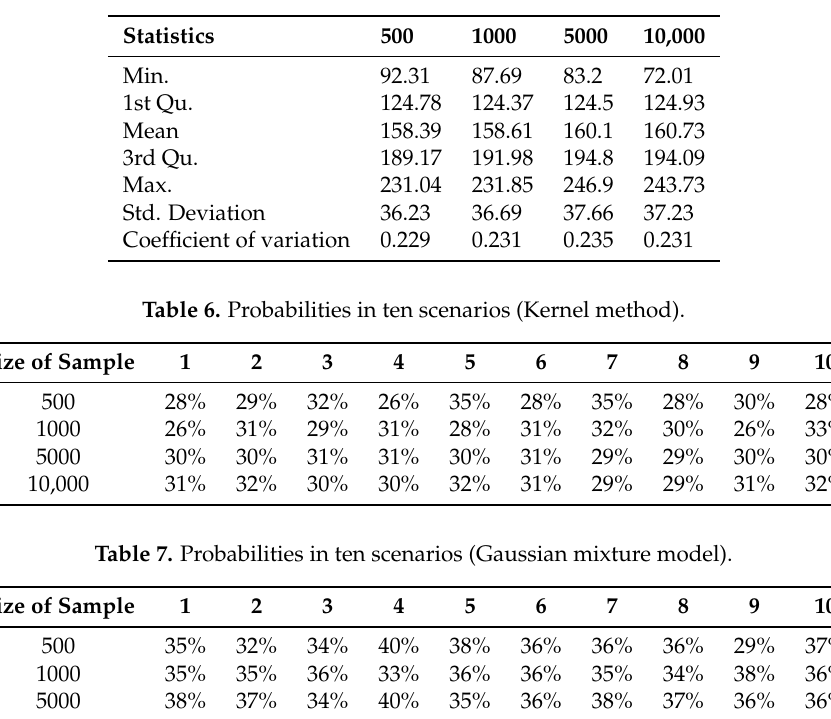
Table 5. Statistical summary of the samples (500, 1000, 5000, and 10,000 iterations) generated via MCMC using the Gaussian mixture model.